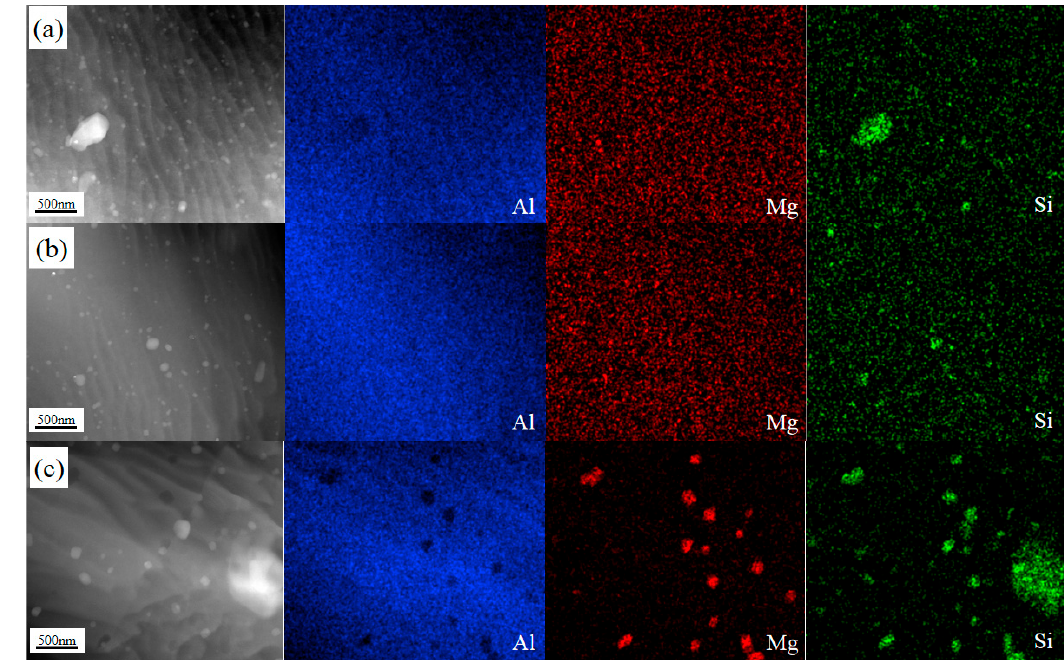
Figure 14. STEM-HAADF and EDS of ( a ) SZ-1; ( b ) SZ-2 and ( c ) SZ-3.